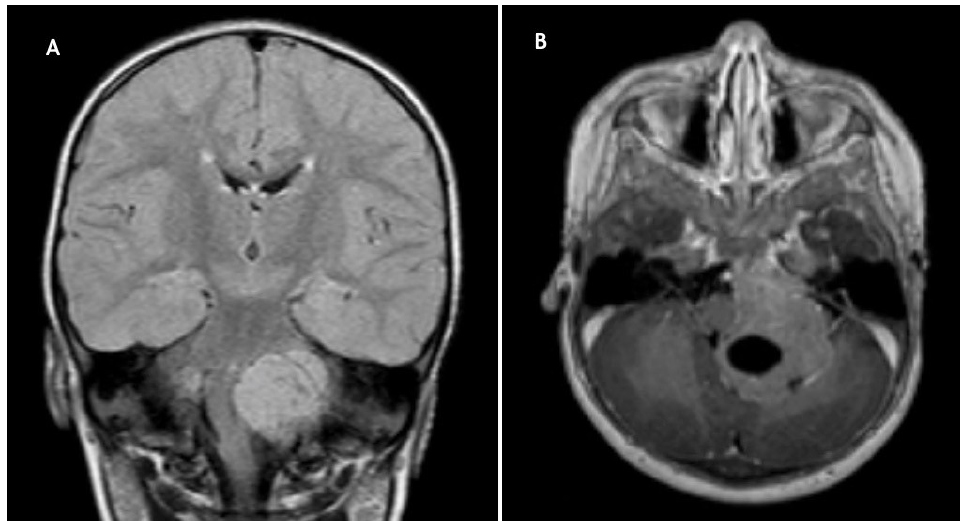
Figure 6. 11 months old girl with swallowing difficulties and facial palsy. FLAIR MRI ( A ) and contrasted T1 MRI ( B ) shows enhancing tumor invading the cerebellum from the left cerebellopontine angle. Diagnosis: anaplastic ependymoma, PFA-type. Therapy: after NTR chemotherapy (HIT-MED Therapy Guidance modified SKK) and proton-beam irradiation, early local recurrence during adju- vant treatment and re-resection, 3rd look surgery for tumor residual after radiation therapy termi- nation.